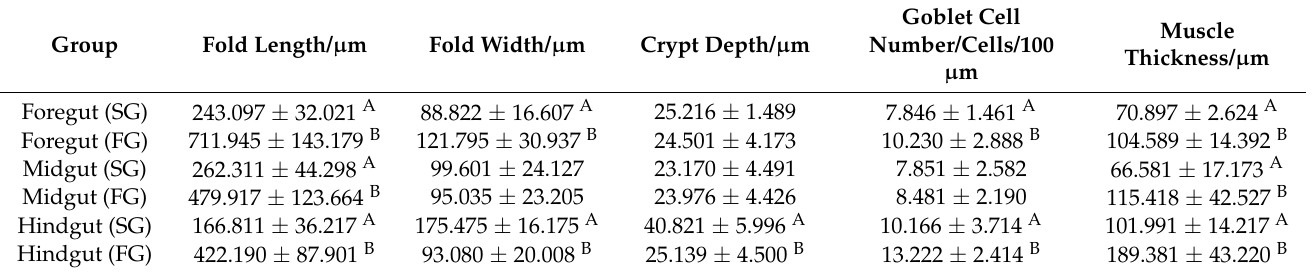
Table 1. Measurement of intestinal parameters of juvenile largemouth bass with different growth rates.